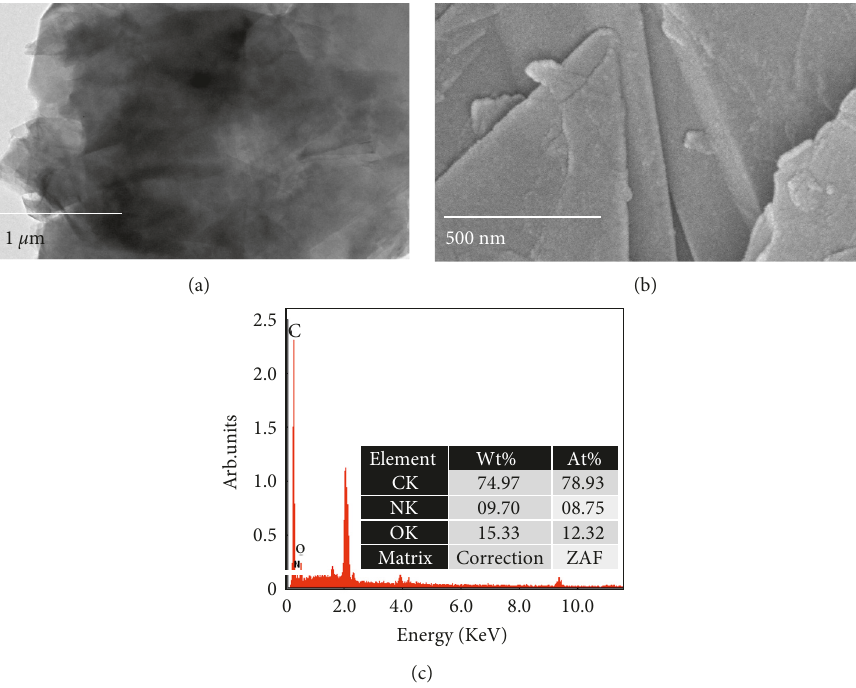
Figure 2: (a) FETEM image of graphene. (b) FESEM image of graphene. Images show a clear shaped flake with a uniform distribution. (c) EDX for graphene. The EDX result confirms that the major elements in graphene are carbon (74.97%) and O (15.33%).